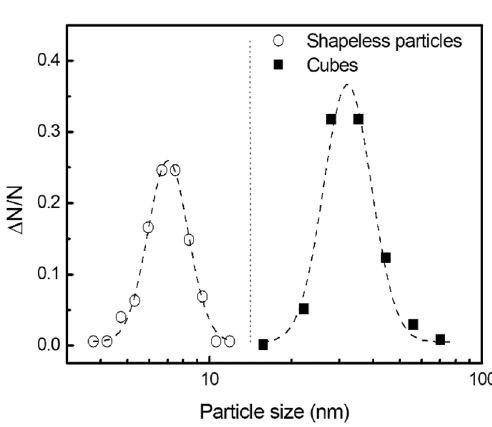
Figure 6. Size distribution of MgO particles collected from the neutral flame (adapted from 13 ). The gap between PSDs is clearly seen in the size range of 10–15